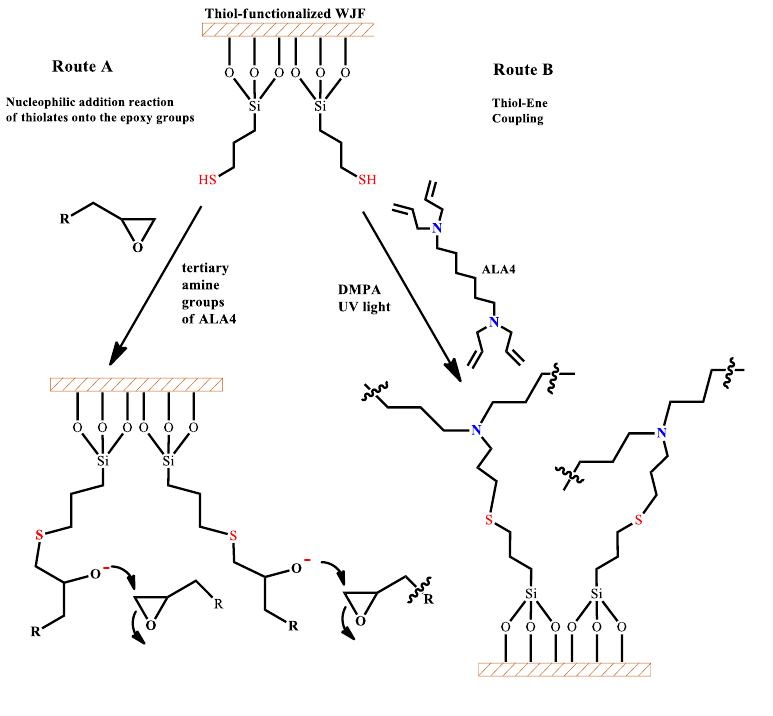
The thiol groups anchored to the WJF can interact with the components of the